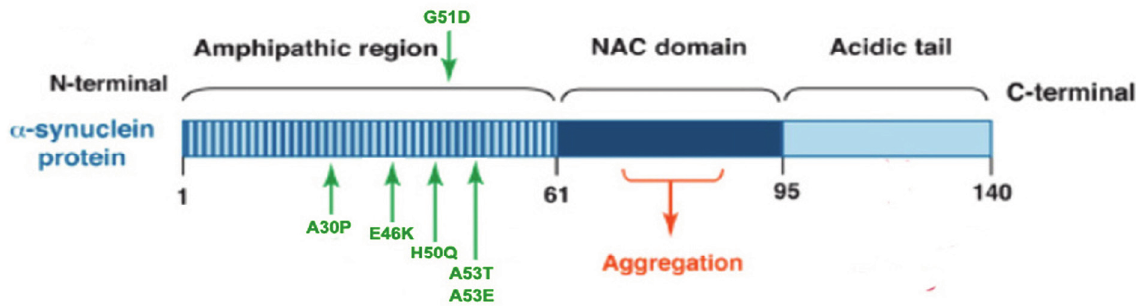
Figure 1. (cid:2)-Synuclein ((cid:2)-syn) protein domain structure. (cid:2)-Syn is a 140 amino acid protein and its sequence can be divided into three regions with distinct structural characteristics. The highly conserved N-terminal domain encodes for a series of imperfect 11 amino acid repeats with a consensus motif of KTKEGV reminiscent of the lipid-binding domain of apolipoproteins, which in certain conditions forms amphipathic helices. The six missense mutations known to cause familial PD (A30P, E46K, H50Q, G51D, A53E and A53T) lie in the amphipathic region, suggesting an important function for this region of the protein. The central hydrophobic region (non-amyloid-(cid:3) component or NAC domain) of (cid:2)-synuclein is associated with an increased propensity of the protein to form fibrils [58]. The acidic C-terminal tail contains mostly negatively charged residues and is largely